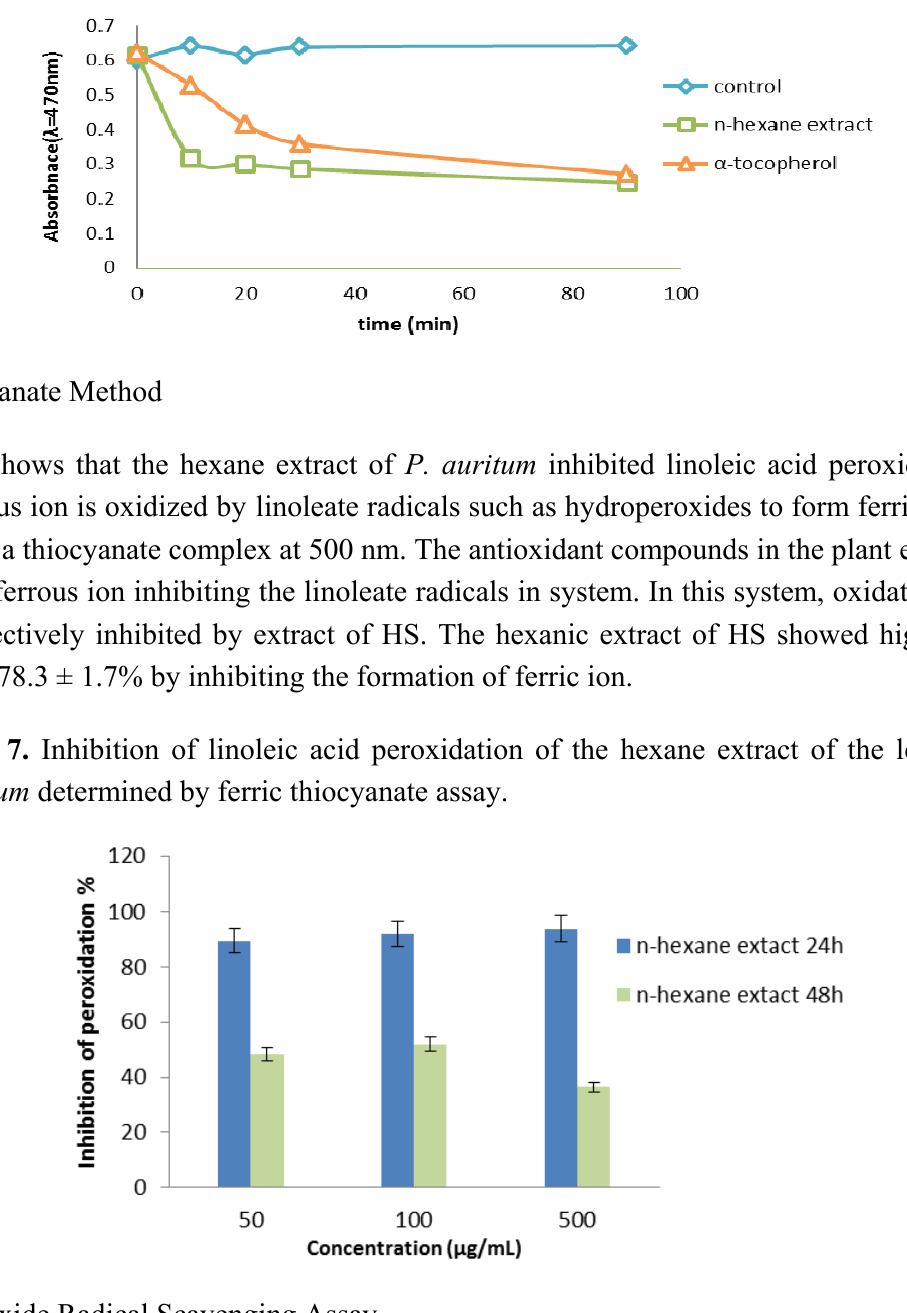
Figure 6. β -carotene scavenging activity ( BCB) assay of HS and α -tocoferol. Values are mean ± SEM and significantly p < 0.05.